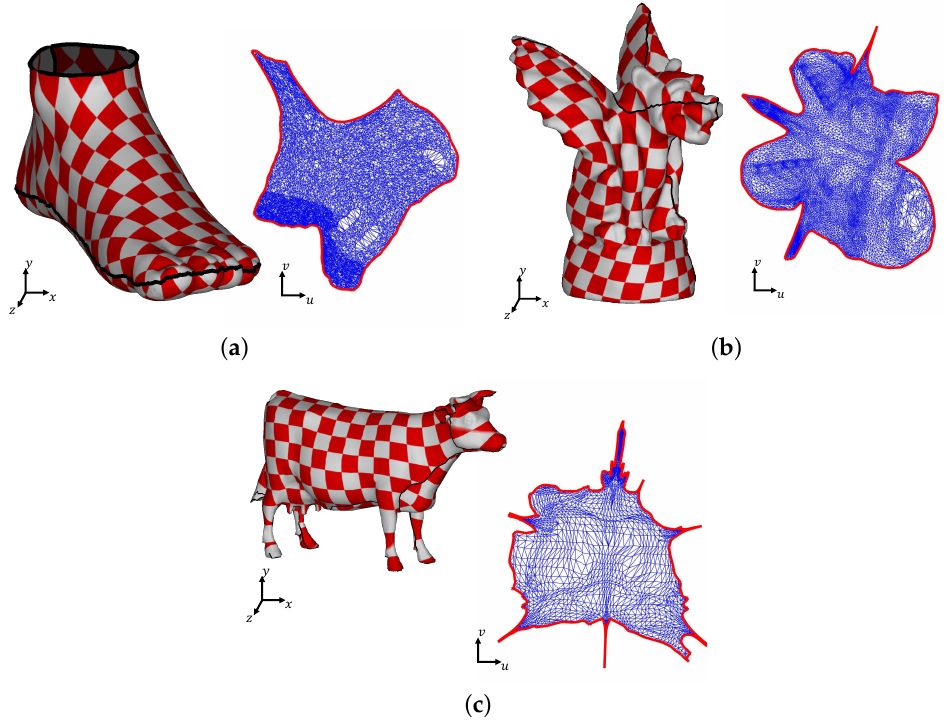
Figure 13. Heat-geodesic parameterization of seam meshes [30]. The strong nondevelopability of the meshes produces high parameterization distortions and in some cases nonbijectiveness. ( a ) Data set Foot. Bijective parameterization. ( b ) Data set Gargoyle. Bijective parameterization. ( c ) Data set Cow. Nonbijective parameterization near the legs and